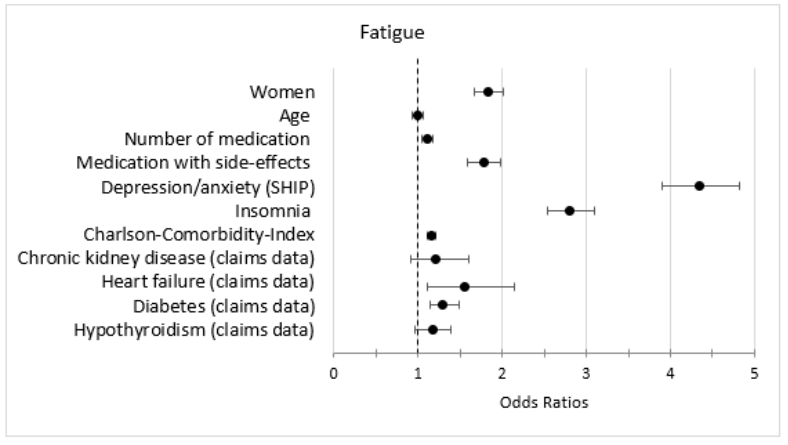
Figure 3. Bivariate logistic regression models (anemia + second variable) with the outcome fatigue; only the estimates (odds ratios and 95% confidence intervals) of the second variable is shown, (weighted).